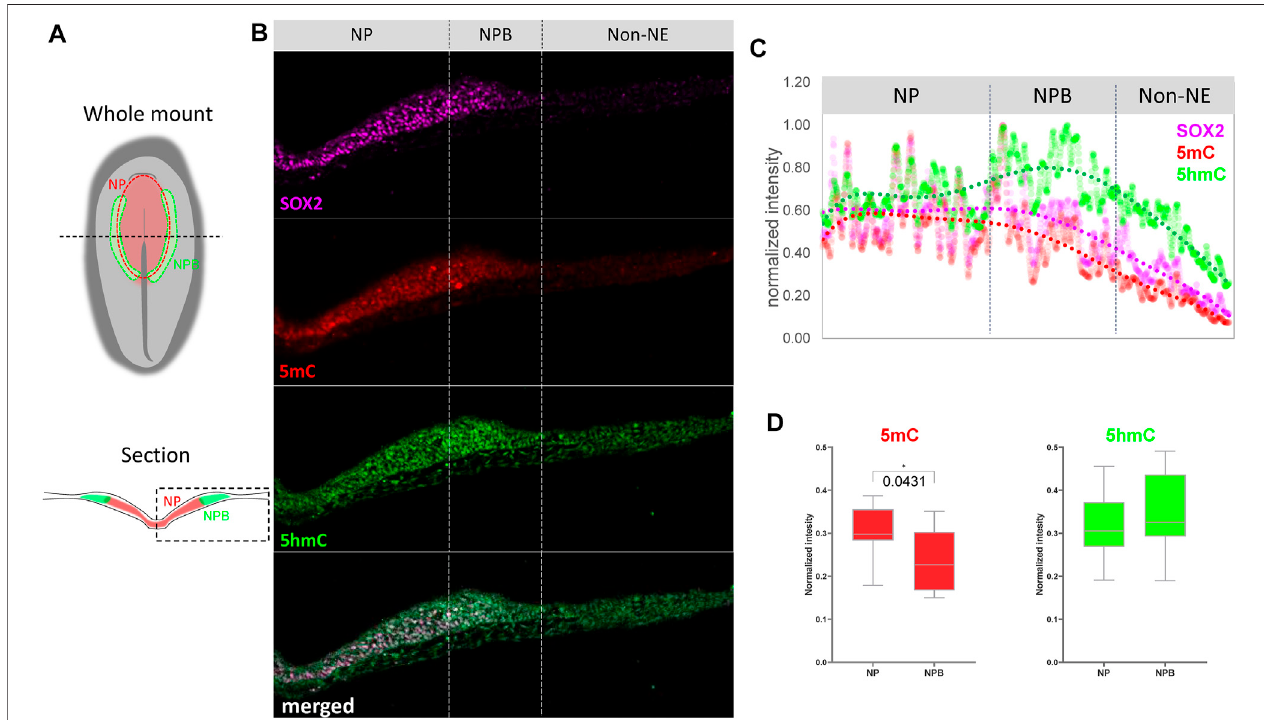
FIGURE2| Abundanceof5mCand5 hm CattheNPandNPB. (A) SchematicdiagramsofchickenembryoatHH6showingtherespectivepositionsoftheneural plate (NP) and neural plate border (NPB). Dashed line in the whole mount indicates level of section. Dashed box in section indicate the area displayed in (B) Transverse sections of embryos at HH6 were coimmunostaining for 5mC (red), 5 hmC (green), and SOX2 (magenta). Dashed lines indicate the NP, NPB, and Non-NE regions. See Supplementary Figure S1 for magni fi cation of the NP/NPB boundary. (C) Intensity pro fi les for 5mC (red), 5 hmC (green) and SOX2 (magenta) across the NP, NPB,andNon-NEfrommedialtolateral. (D) Quanti fi cationof5mCand5 hmCnormalizedintensityatthenucleusofeachcellalongtheNPandNPBatHH6(2-5section/ embryo. n = 4). Asterisk indicates signi fi cance as calculated using Student ’ s t -test. See Supplementary Figure S1 for the negative control of 5mC and 5 hmC immunostaining omitting the primary